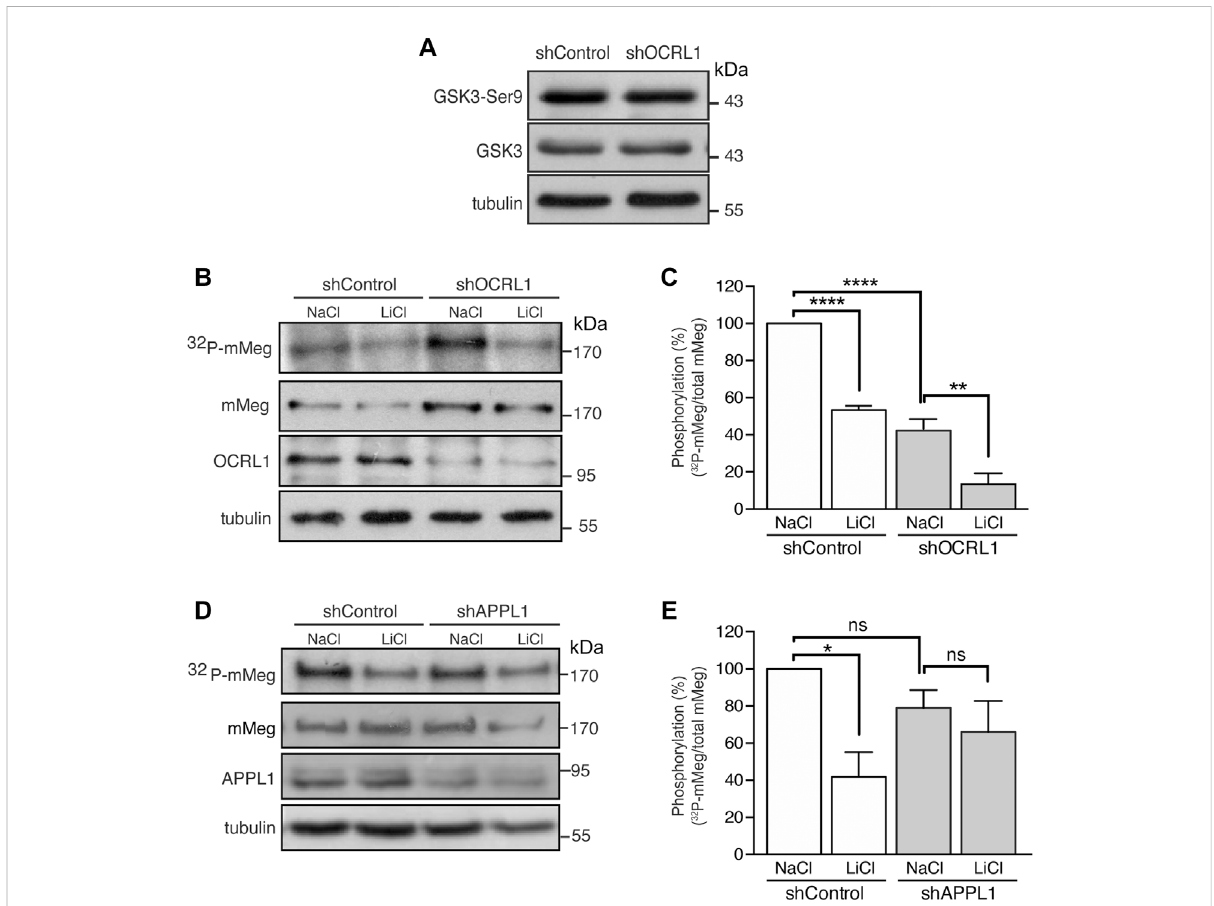
FIGURE 4 Reduced mMeg phosphorylation in mMeg-MDCK OCRL1 silenced cells. (A) Control or OCRL1 silenced cells were lysed and analyzed by western blot with antibodies against phosphorylated GSK3ß (Ser9) and total GSK3ß. (B) Control or silenced for OCRL were treated with LiCl (50 mM) or NaCl (50 mM) as control. For phosphorylation assays, the cells were incubated with [ 32 P]-orthophosphate for 2 h at 37 ° C, followed by immunoprecipitation of megalin from cell lysates using an anti-megalin cytoplasmic domain. The immune complexes were analyzed by SDS- PAGE and visualized byautoradiography. Aliquots ofwhole-celllysates wereused to detect mMeg by western blot. (C) Graph shows the percentage of phosphorylated mMeg related to the total. Data are expressed as the means ± SEM of N = 3 independent experiments (ANOVA, **** p < 0.0001, ** p < 0.01). (D) Control or silenced for APPL1 were treated with LiCl (50 mM) or NaCl (50 mM) as control. For phosphorylation assays, the cells were incubated with [ 32 P]-orthophosphate for 2 h at 37 ° C, followed by immunoprecipitation of megalin from cell lysates using an anti-megalin cytoplasmic domain. The immune complexes were analyzed by SDS-PAGE and visualized by autoradiography. Aliquots of whole-cell lysates were used to detect mMeg by western blot (E) Graph corresponds to the percentage of phosphorylated mMeg related to the total of control or APPL1 silenced cells. Data are expressed as the means ± SEM of N = 3 independent experiments (ANOVA, * p <